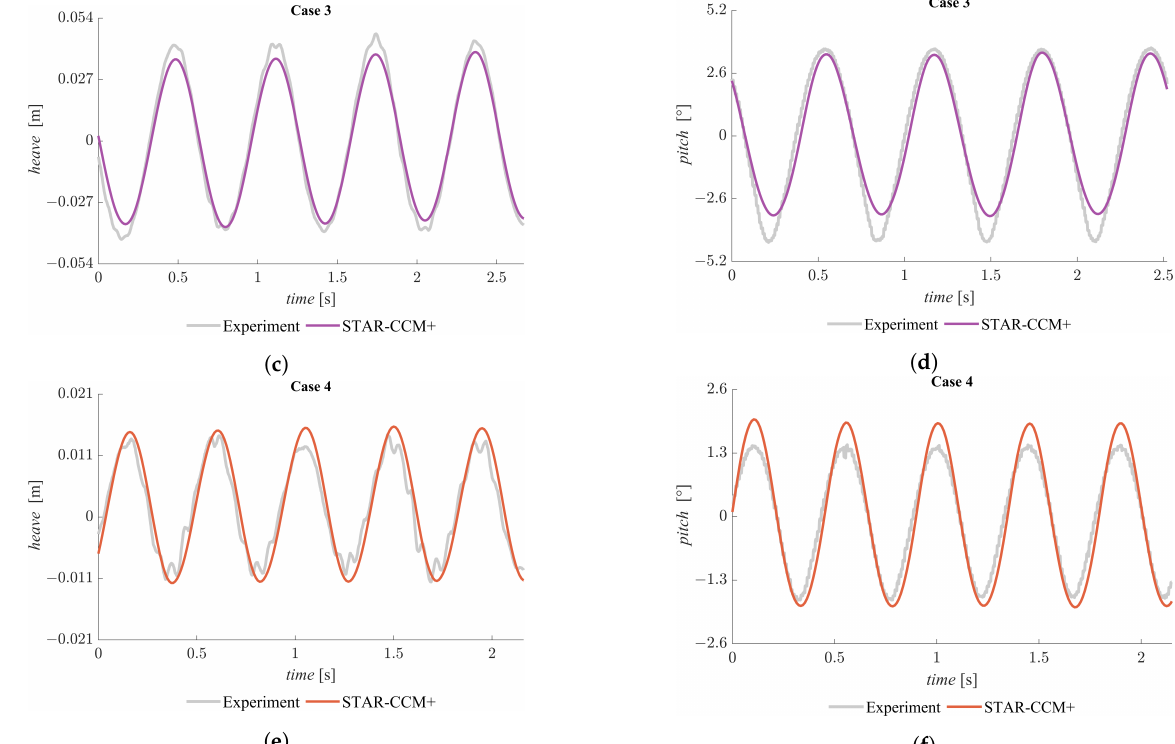
Figure 6. Experimental and numerical hull motions (heave and pitch) for 3 of the evaluated wave